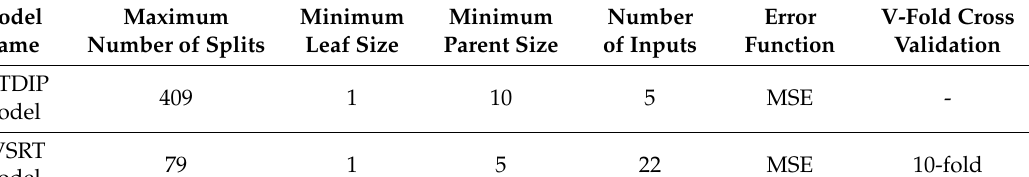
Table 3. Regression tree models to predict thermal energy production.